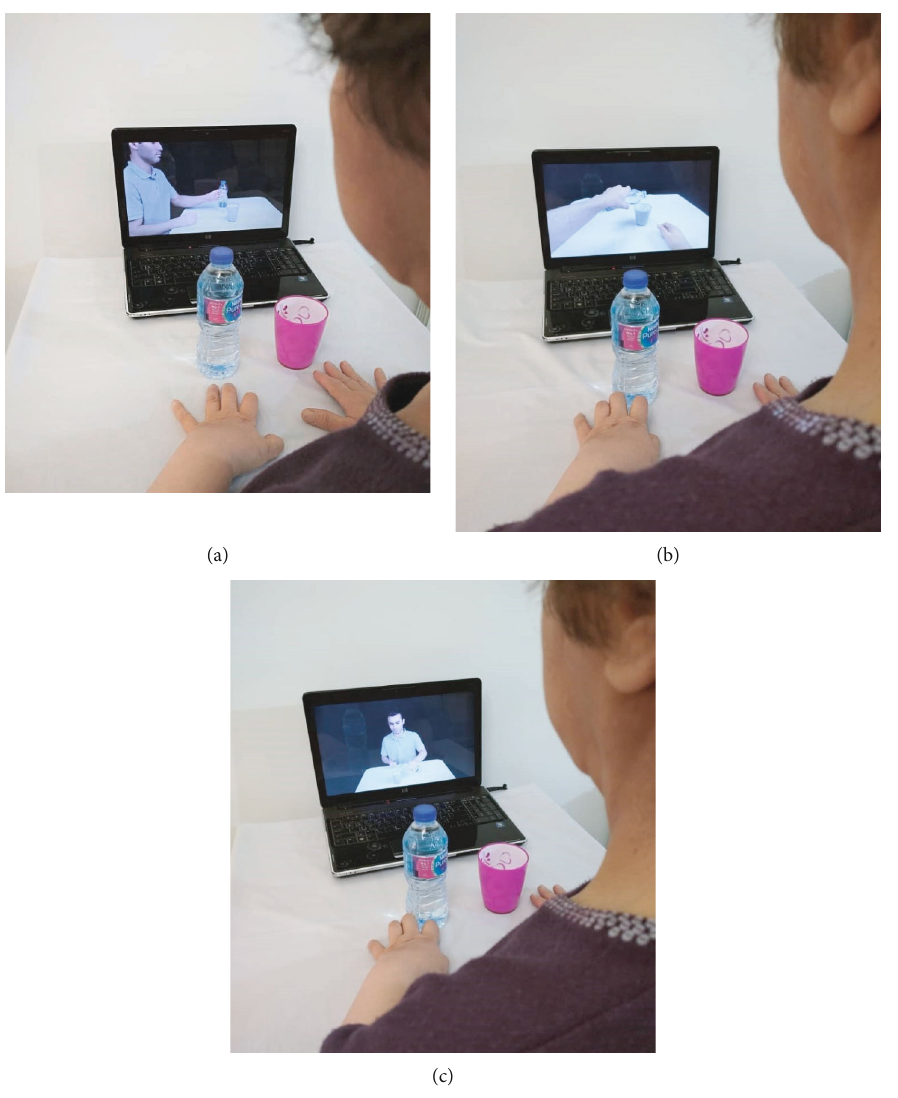
Figure 2: A left hemiplegic patient in AOT group watching AOT videos of (a) lateral view, (b) point of view, and (c) front